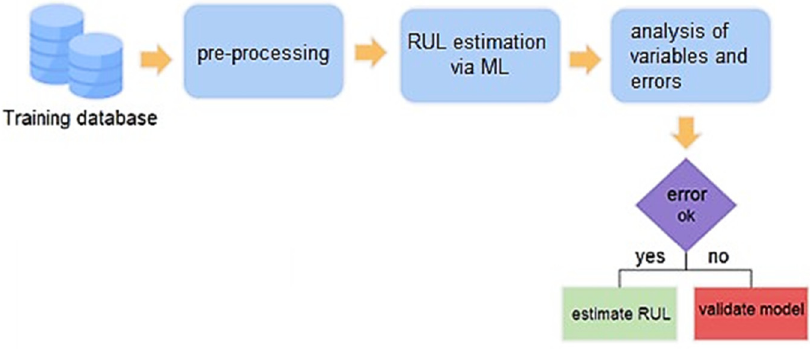
Figure 7. Training and validation of the RUL model estimation for each RUT [authors].